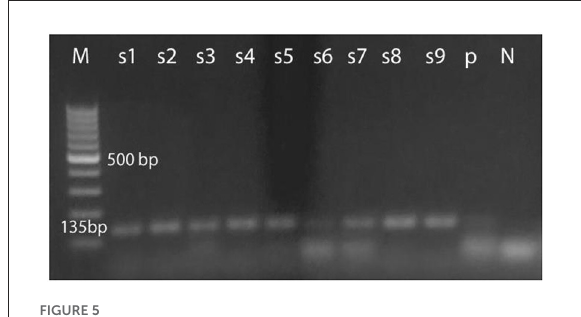
FIGURE5 Tobacco in tomato seeds mosaic tobamovirus view of the result of the RT-PCR test applied to the gel imaging system.